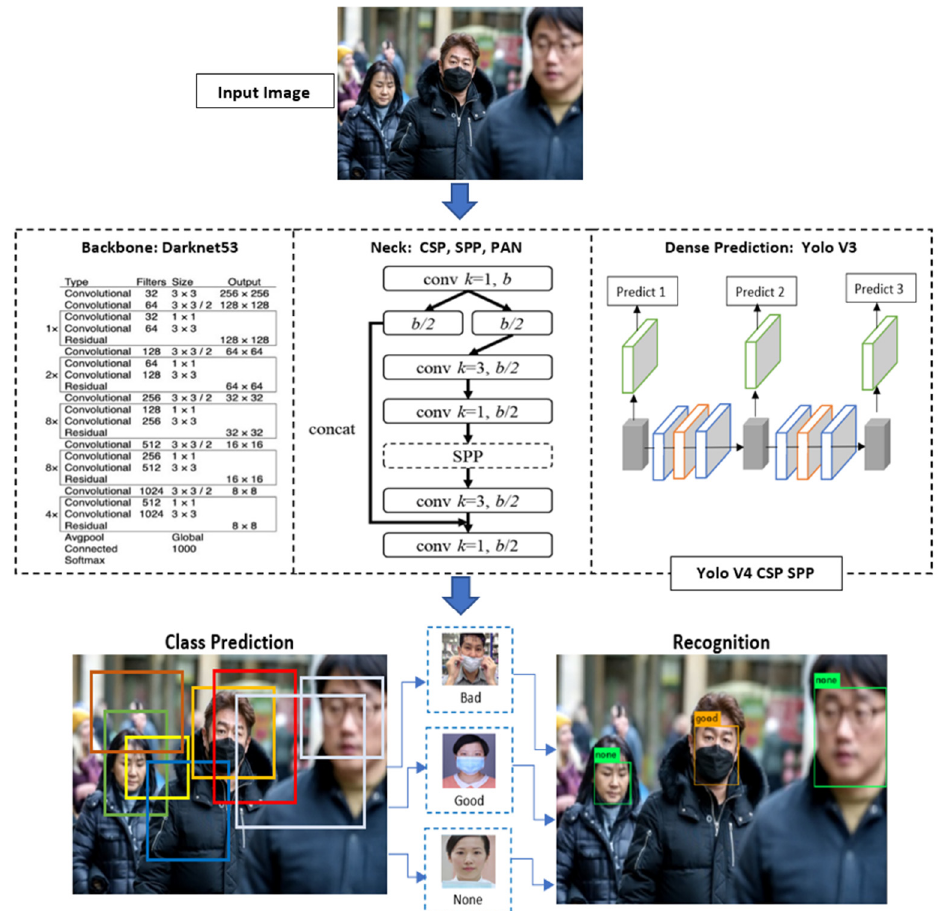
Figure 2. System Architecture of Yolo V4 CSP SPP. Source of the human faces: The FMD and MMD datasets.